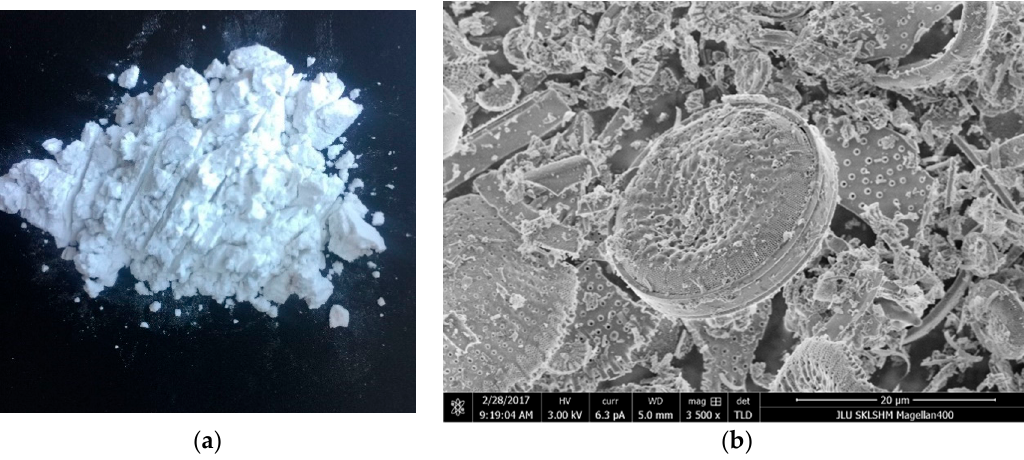
Figure 1. The Grading Curve aggregates used in this study.